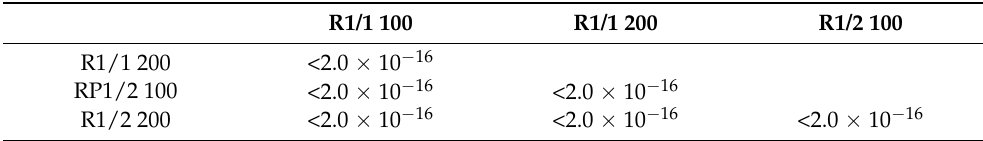
Table 3. Results of Mann–Whitney–Wilcoxon statistical